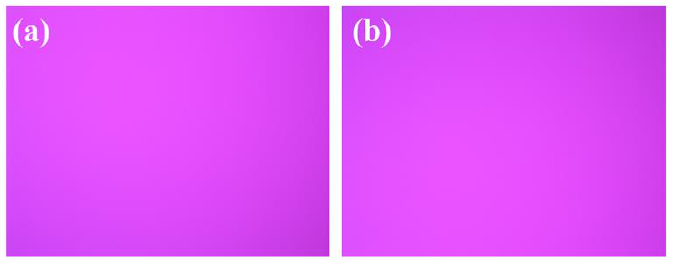
Figure 7. Microemulsion of AGO/Tween ® 20/PG/water system was isotropic under polarizing light microscope before ( a ) and after ( b ) the stability test under heating–cooling conditions. The magnification was 10×.